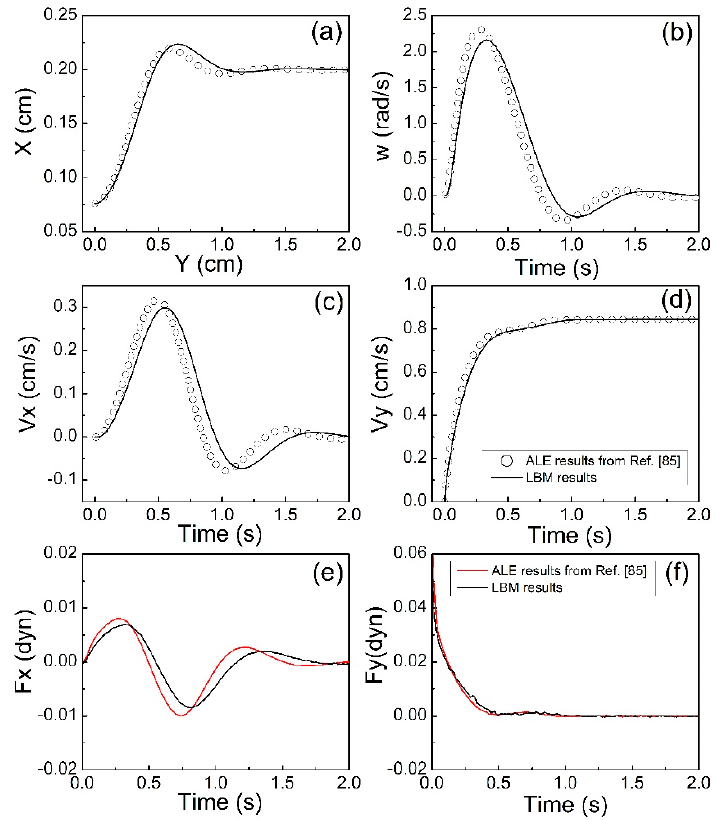
Figure 9. Time-dependent ( a ) particle trajectory, ( b ) angular velocity, ( c ) horizontal velocity, ( d ) vertical velocity, ( e ) horizontal force and ( f ) vertical force.